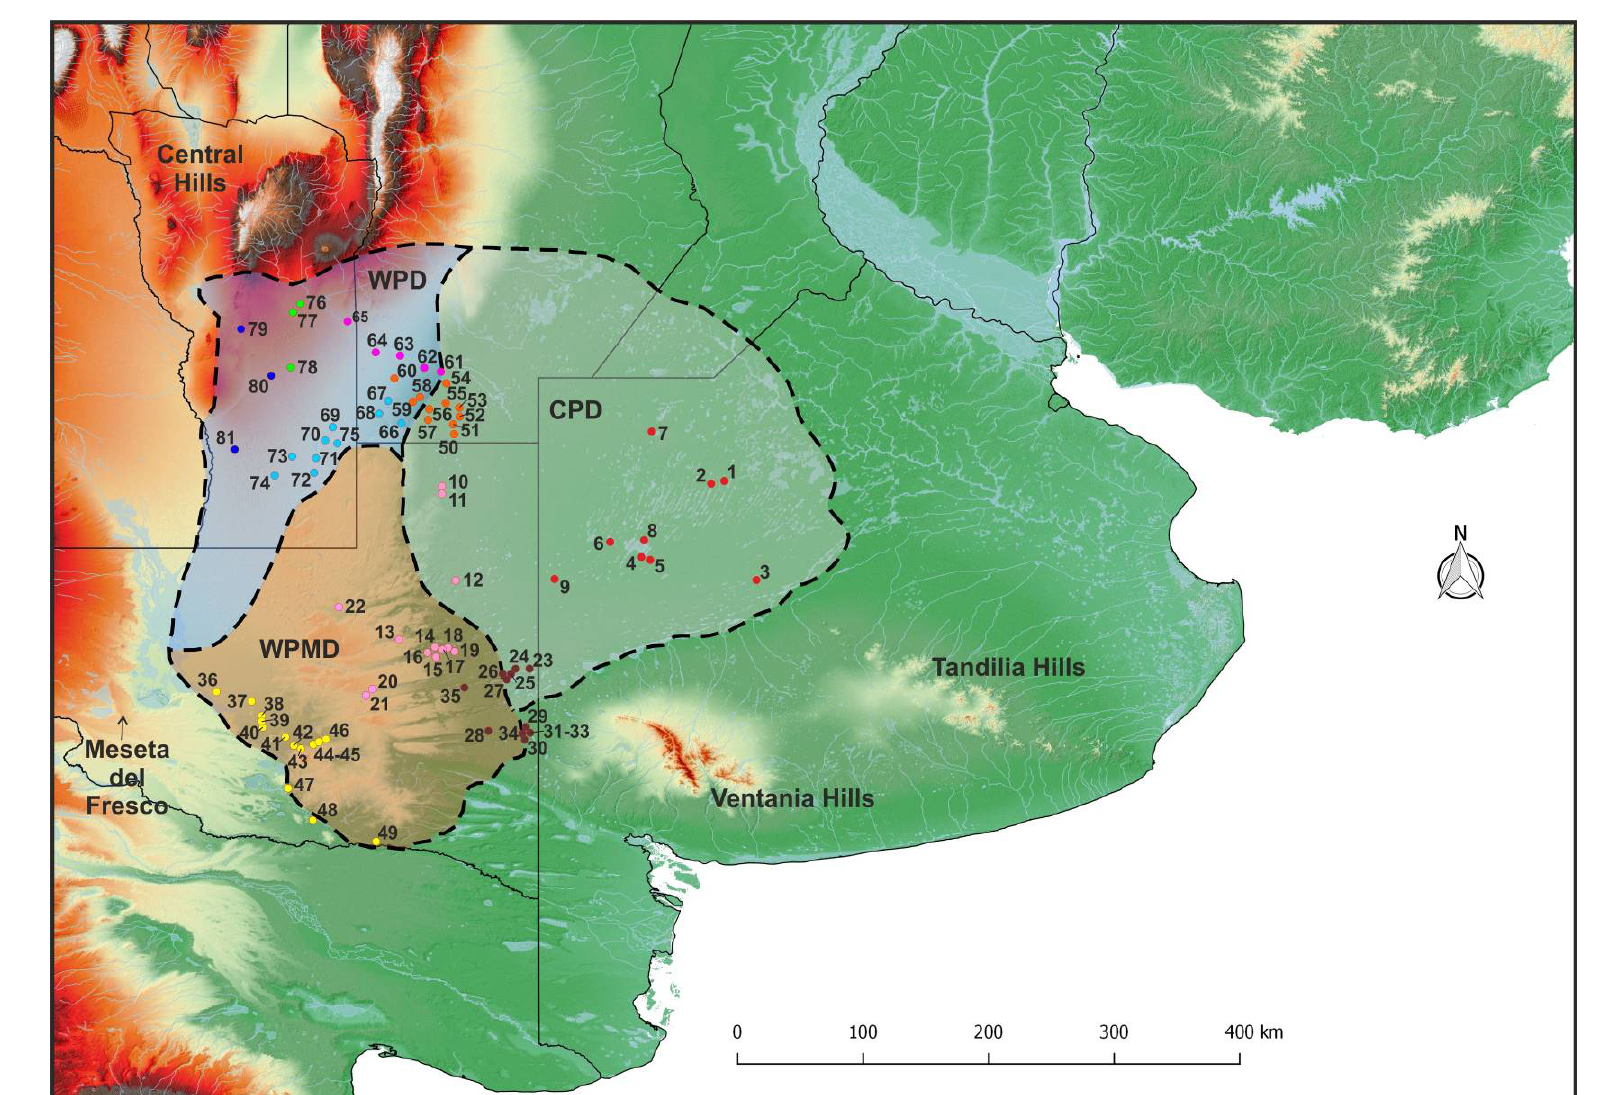
Figure 2. Locations of lithic assemblages plotted on the center-east of Argentina. Numbers are associated with the site names and assemblages are colored by